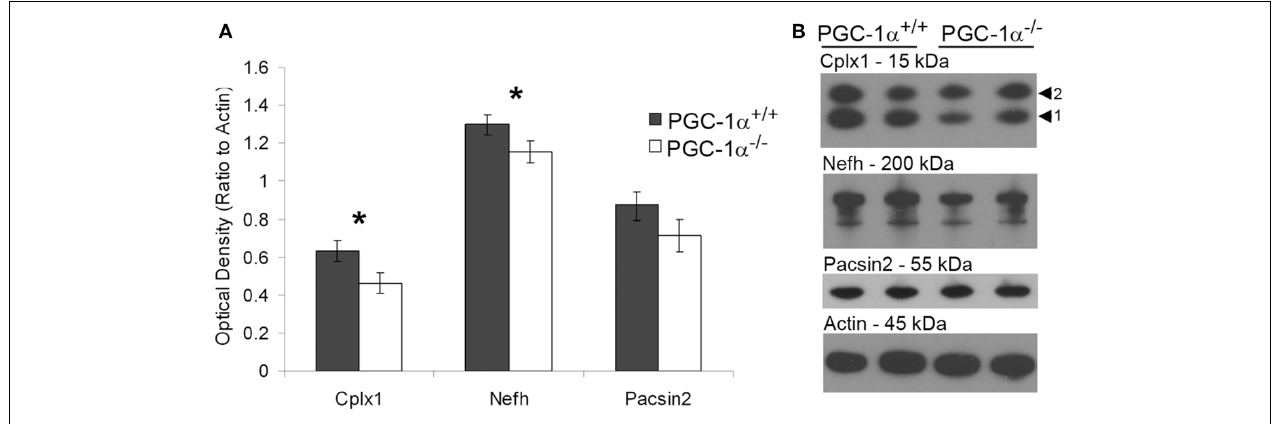
similar manner as the transcript. Expression of Cplx1 and Nefh, but not Pacsin2, was significantly reduced in − / − compared to + / + animals (A) . Representative Western blots are shown in (B) . One-tailed t -tests. ∗ p < 0 . 05 . n = 7 /group. Data are presented as mean ±